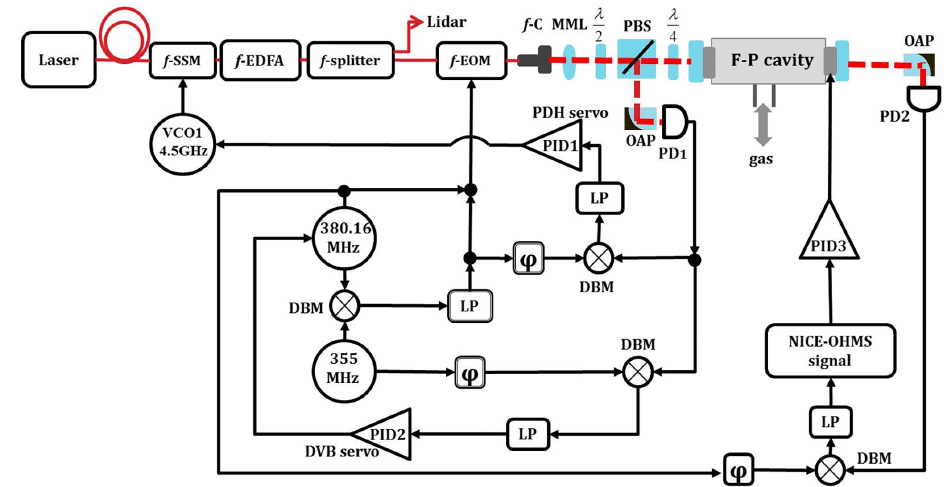
Figure 1. Experimental setup: f-SSM, fiber-coupled single-sideband electronic optical modulator; f-EDFA, fiber-coupled erbium-doped fiber amplifier; f-EOM, fiber-coupled electronic optical phase modulator; f-C, fiber collimator; MML, mode-matching lens; λ/ 2, half-wave plate; PBS, polarizing beam splitter; λ/ 4, quarter-wave plate; OAP, off-axis parabolic mirror; PD, photodetector; LP, low-pass filter; PID, proportional–integral–derivative controller; VCO, voltage control oscillator; DBM, double balanced mixer; ϕ , phase shifter; DVB servo, DeVoe–Brewer servo; F-P cavity, Fabry–Pérot cavity.